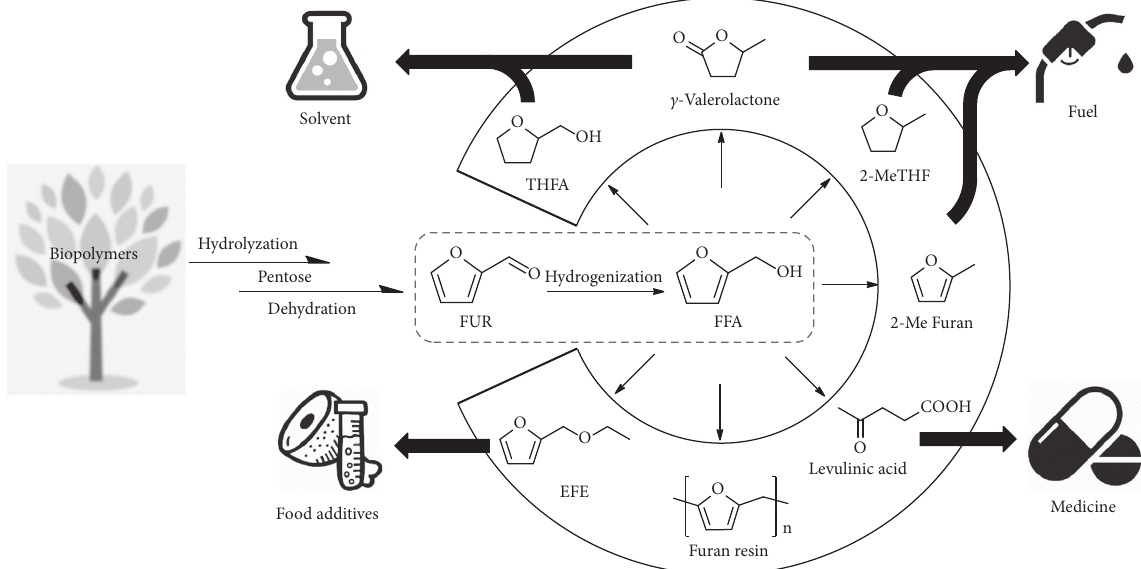
Figure 1: Biomass valorization by the hydrogenation of FUR to FFA. FUR: furfural; FFA: furfuryl alcohol; EFE: 2-(ethoxymethyl) furan; THFA: tetrahydrofurfuryl alcohol; 2-Me THF: 2-methyltetrahydrofuran; 2-MeFuran: